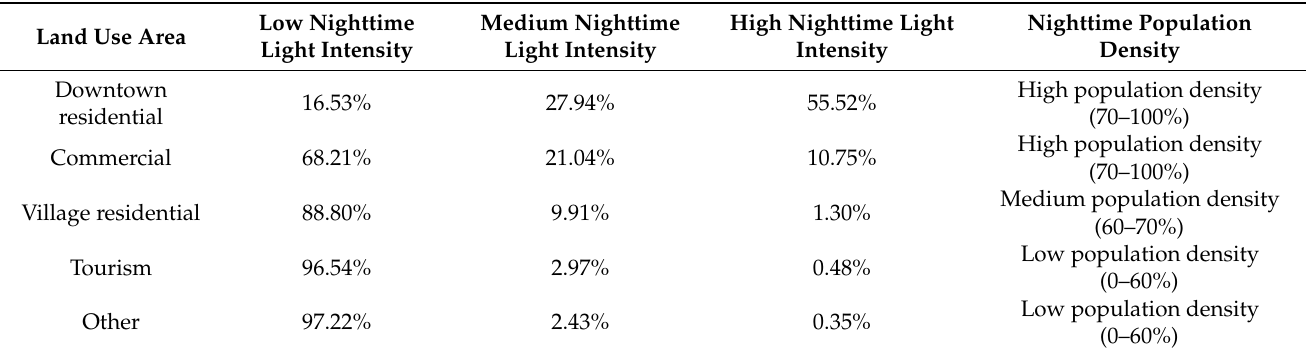
Table 3. Population densities of the different land use areas in Haikou city according to the percentage of nighttime light